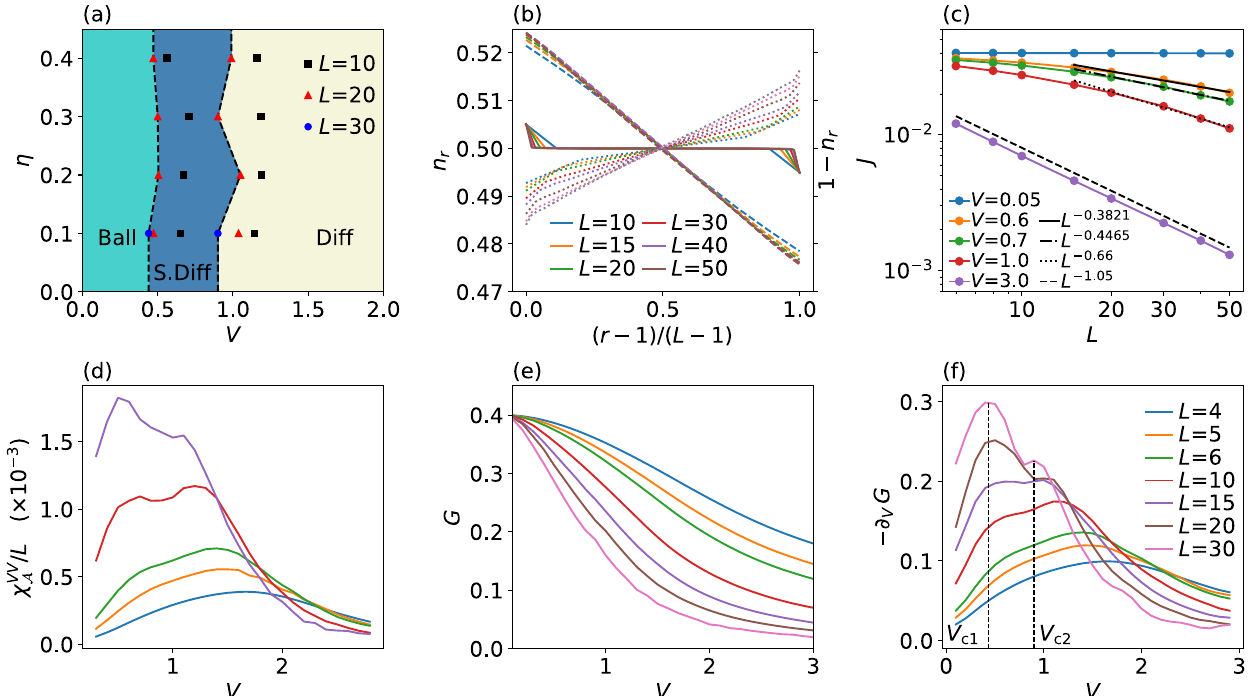
Fig. 3 Results for the fermionic ladder. a Tentative fi nite-sized phase diagram, showing a ballistic (Ball), diffusive (Diff), and super-diffusive (S. Diff) regimes. Phase boundaries lines are based on the largest converged system size. The symbols give the location of the peaks in f for different system sizes showcasing the drift of V c1 and V c2 . b Comparison of the real space occupations between the ballistic phase at V = 0.05 (continuous), the diffusive at V = 3.0 (dashed) and the super-diffusive at V = 0.7 (dotted); all for η = 0.05. For the super-diffusive case (dotted) we showed 1 − n r to avoid overlapping the curves. c Comparison of the L dependence of the current for the different regimes, with η = 0.05. The straight lines serve as guides to the eye for the power-law behavior of the diffusive and super-diffusive phases. d χ VV A = L vs V for different system sizes at η = 0.1 and with δ V = 0.2, detecting a transition from a ballistic to a diffusive phase, while crossing an intermediate super- diffusive regime. The color code for fi gures d – f is given in f . e and f showcase G and − ∂ V G ( fi nite differences) vs V for different L and η = 0.1, with the result in f smoothed with a low-pass fi lter to remove high-frequency